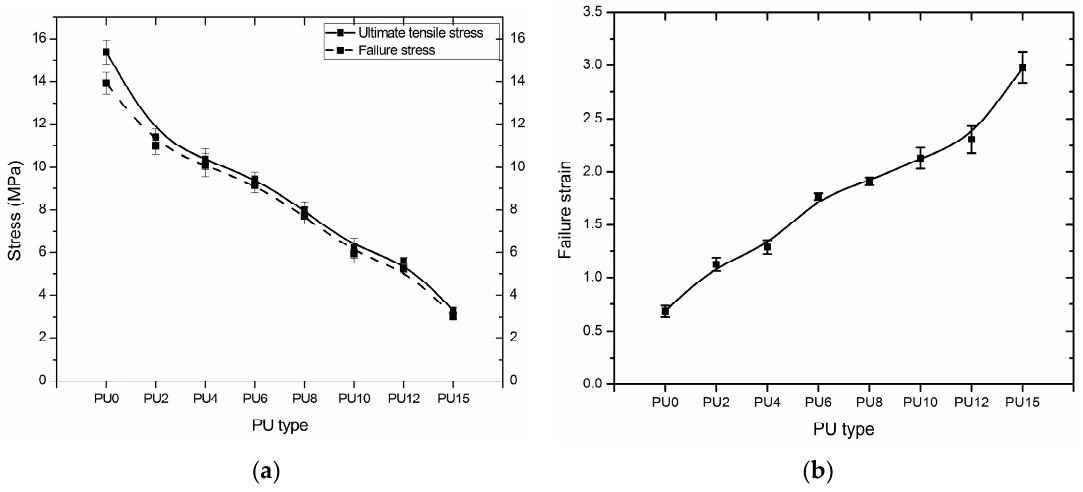
Figure 8. ( a ) Ultimate and failure tensile stress, ( b ) failure strain, of the PUs (PU0–PU15 are types of PU and PU6—PU which contained 6% PEG).